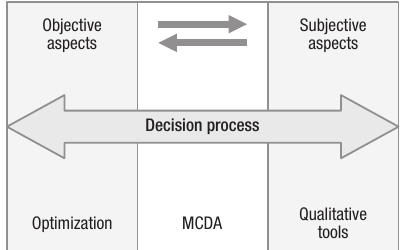
Fig. 2. MCDA conceptual